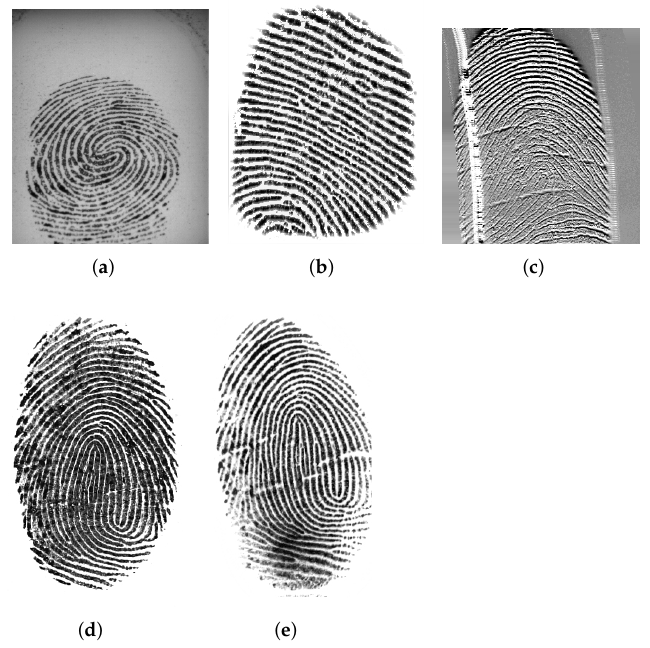
Figure 1. Examples of acquisitions with different sensors: ( a ) Biometrika, ( b ) DigitalPersona, ( c ) Or- canthus, ( d ) GreenBit, ( e ) Dermalog. The characteristics of the images are strictly influenced by the acquisition